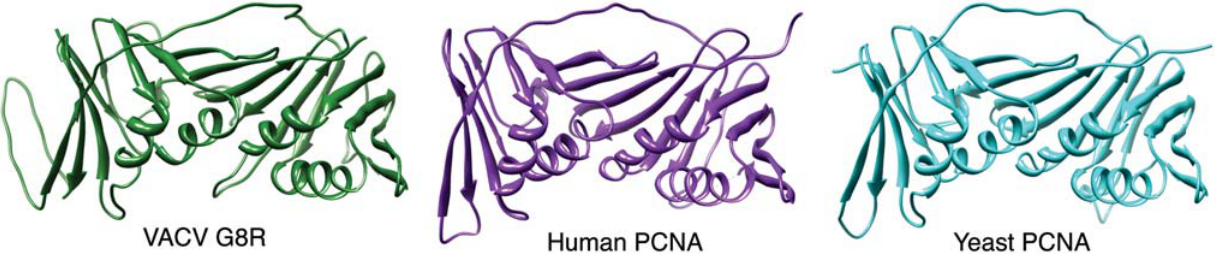
Figure 2. Structures of the VACV G8R (predicted), human and yeast PCNA (experimentally determined) proteins.